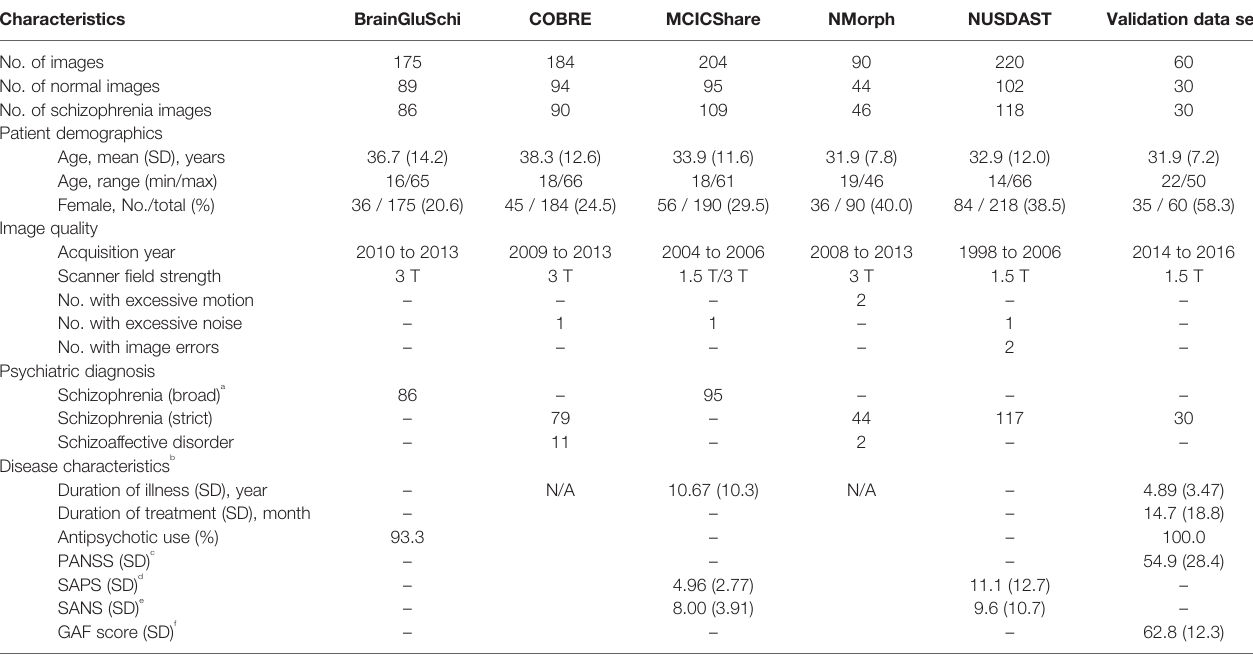
TABLE 1 | Sample characteristics of 5 public schizophrenia MRI and validation data sets.